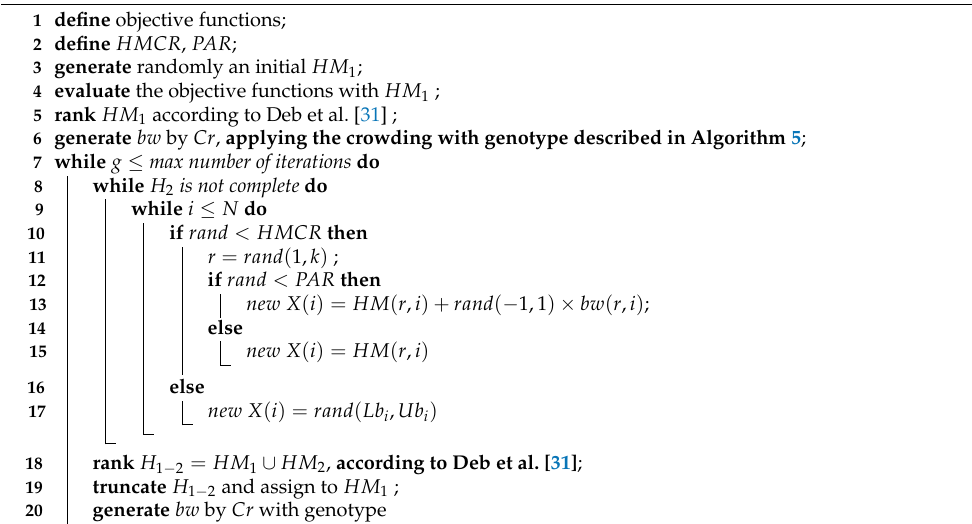
Algorithm 6 Proposed algorithm